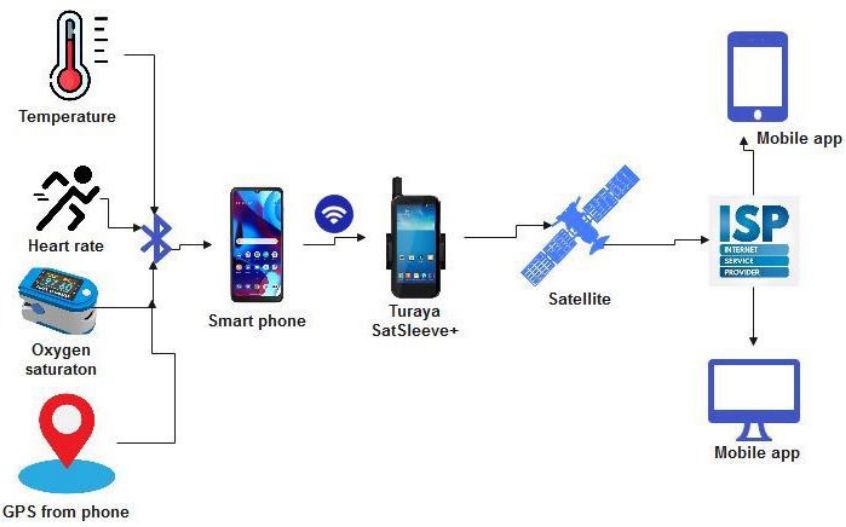
Figure 11. Use of Thuraya Phone for